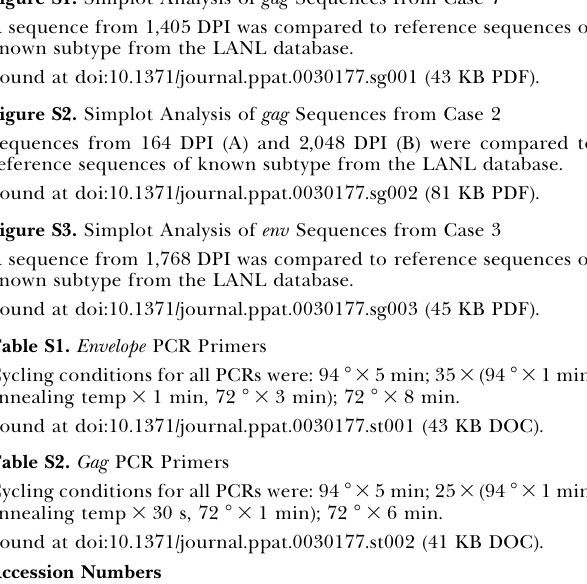
Table S2. Gag PCR